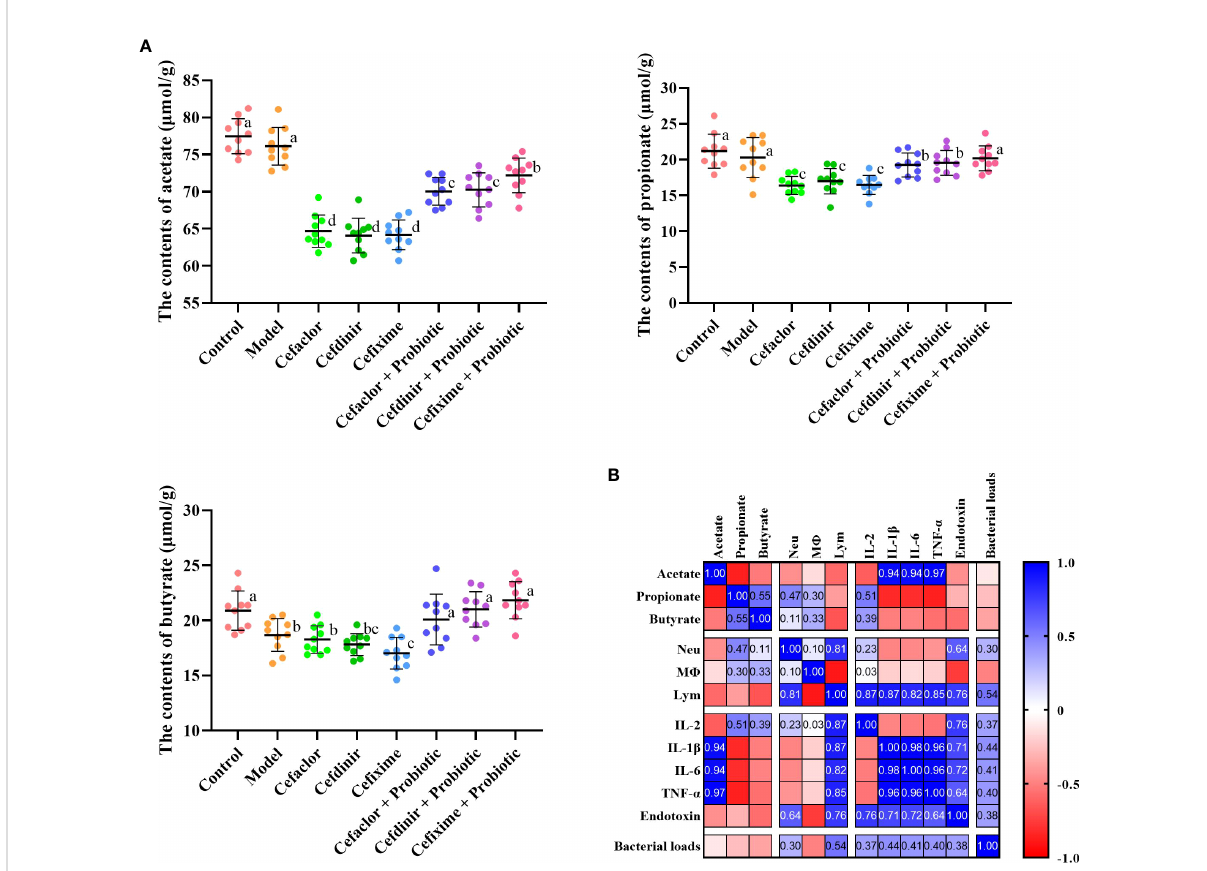
FIGURE 8 Short-chain fatty acids (SCFA) production and the correlation with disease indicators. (A) The concentrations of SCFA in intestinal contents of infected mice. (B) The correlation between SCFA and disease indicators. Neu, neutrophils; M j , macrophages; Lym, lymphocytes. Data were showed as mean ± SD. Different letters indicated statistically signi fi cant differences, P